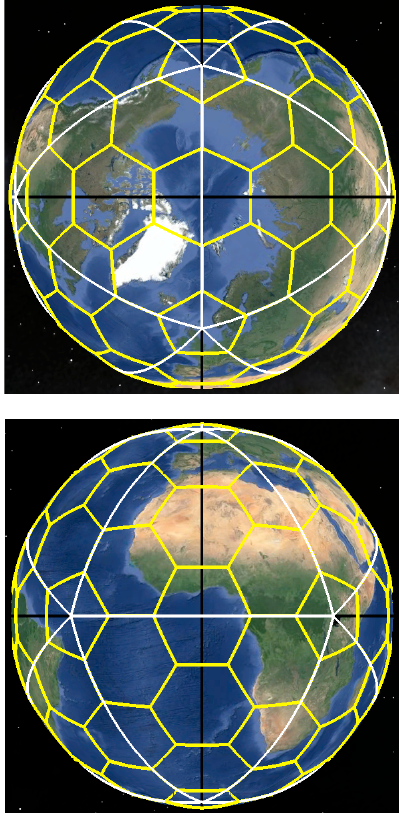
Figure 9. Two views of the CPI43 System base tile cell boundaries, generated on a spherical icosahedron using a grid sequence of one aperture 4 followed by one aperture 3 grid